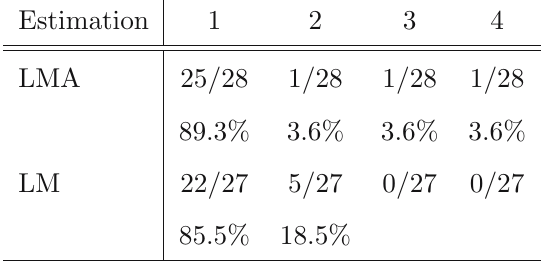
Table 3 Evaluation of “airway-assessment” with use of the different devices; Laryngeal Mask Airway (LMA) and the Laryngeal Tube